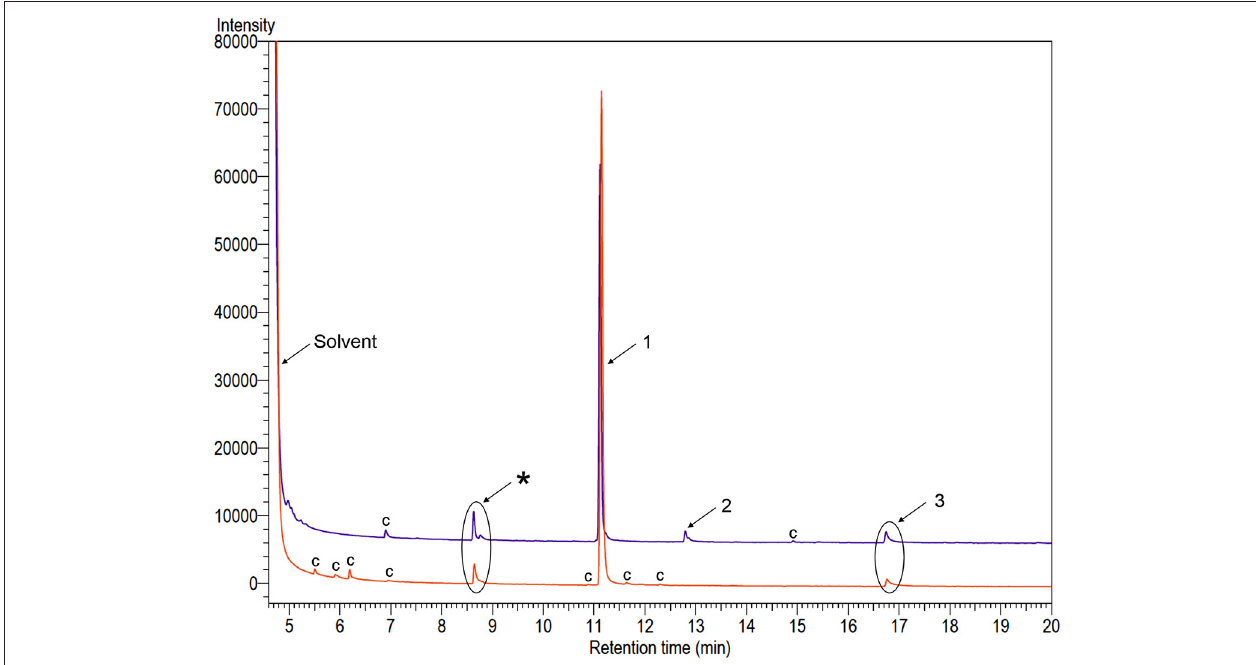
FIGURE 1 | Gas chromatograms of extracts of volatiles produced by adult males of Ambonus distinctus (top purple trace) and Ambonus electus (bottom orange trace). Numbers on peaks indicate sex-specific compounds: (1) ( R )-3-hydroxyhexan-2-one; (2) 3-methylthiopropan-1-ol; and (3) 1-(1 H -pyrrol-2-yl)-1,2-propanedione. The asterisk indicates an analytical artifact, and “c” indicates system contaminants that were found in equivalent extracts of control chambers.